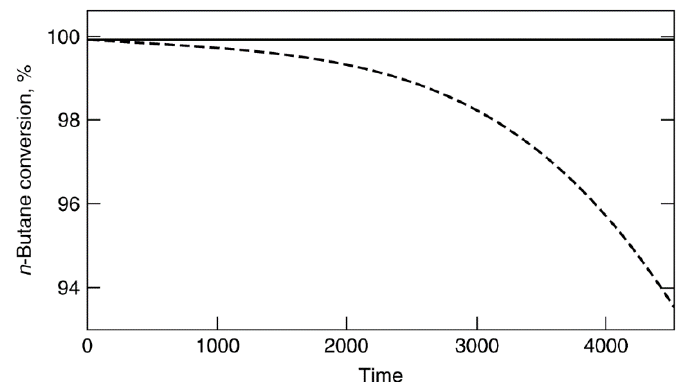
Figure 32. Conversion of n -butane as a function of time during steam reforming in a 3% n –butane–7% hydrogen–3% water in helium mixture at a space velocity of 1.2 h −1 . The dashed curve shows the n -butane conversion for the Ni catalyst (16.8% Ni) and the solid curve for the Au/Ni catalyst (16.4% Ni/0.3% Au). Reproduced from [71]. Copyright 1998, American Association for the Advancement of